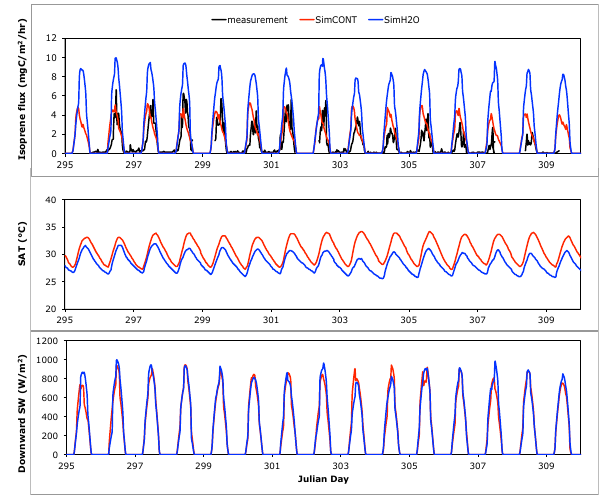
Fig. 7f. (a–f) Time evolution of isoprene emission flux, surface Figure 7f. Results for early dry season Borneo during June 22 - July 22 2008. air temperature (SAT) and downward shortwave (SW) radiation at the tropical measurement sites. Measurements are shown in black (where data is available). Model climatological results are averages of 10 simulation years in SimCONT (red) and SimH2O (blue). (f) early dry season Borneo during 22 June–22 July 2008.